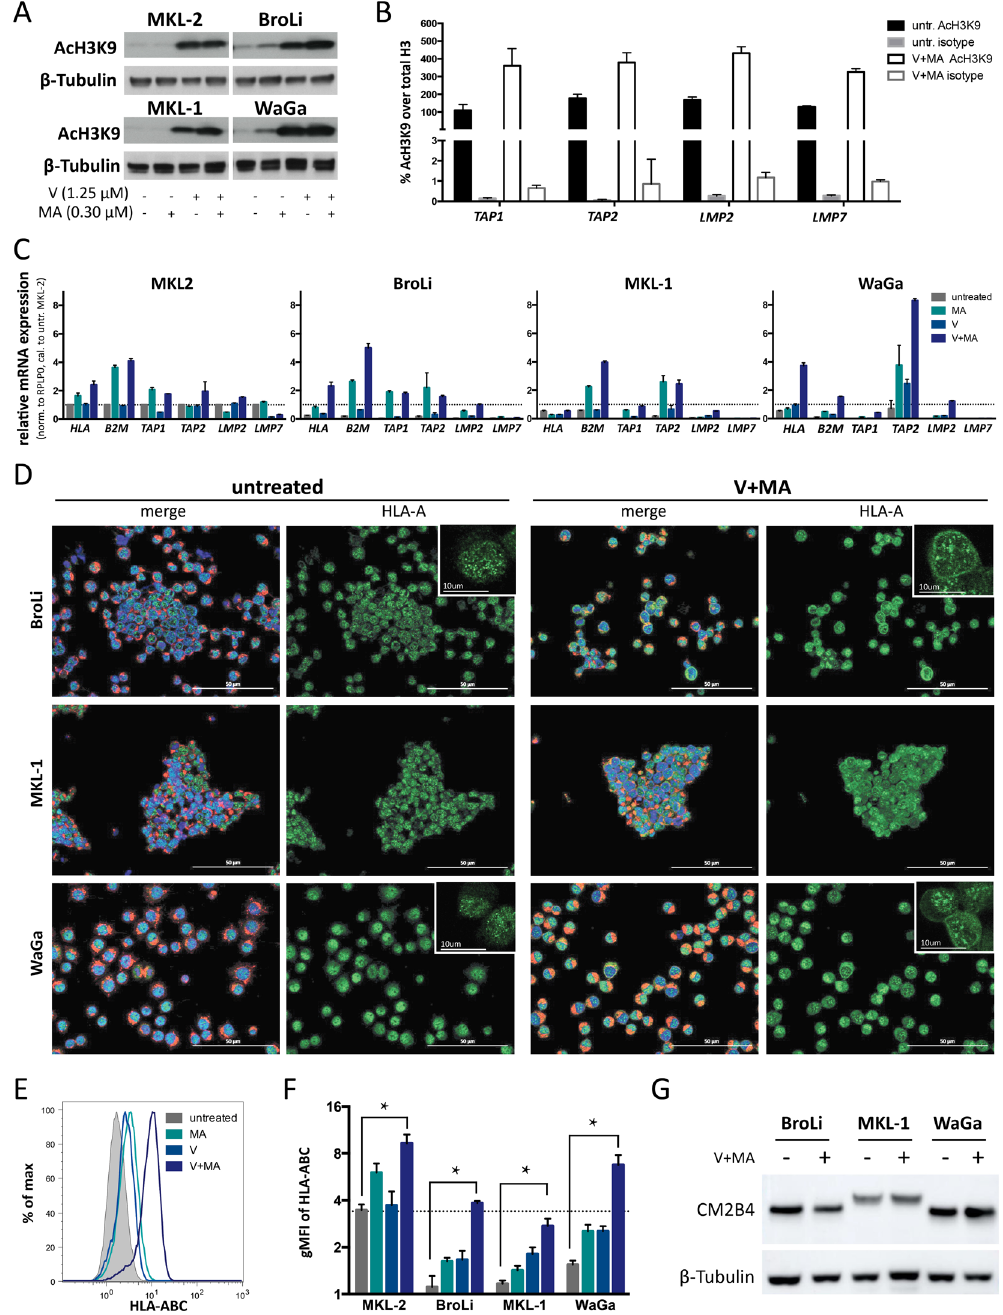
Figure 3. Reduced expression of antigen processing machinery genes is mediated by histone hypoacetylation and is increased by pharmacologic histone deactylase inhibition. For all experiments the indicated MCC cell lines were analyzed without treatment (grey) and after treatment with mithramycin A (MA, turquoise), vorinostat (V, light blue), or the combination thereof (V + MA, dark blue). ( A ) Global H3K9 acetylation of untreated, V, MA or V + MA treated MCC cell lines was determined by immunoblot with an AcH3K9 antibody; β -tubulin served as loading control. ( B ) Chromatin immunoprecipitation (ChIP) assay was performed with untreated or V + MA treated WaGa cells followed by a qRT-PCR using TAP1 , TAP2 , LMP2 or LMP7 promoter specific primers. C T values of AcH3K9 antibody or rabbit IgG isotype precipitated DNA were normalized to histone H3 antibody precipitated DNA as described in material and methods. Experiments were performed in triplicates twice and results are expressed as mean + SEM. ( C ) mRNA expression of HLA-A , B2M , TAP1 , TAP2 , LMP2 and LMP7 was determined by RT-qPCR in triplicates; C T values were normalized to RPLP0 and calibrated to the Δ C T value of untreated MKL-2 cells; relative mRNA expression is depicted + SEM for MKL-2, BroLi, MKL-1 and WaGa. ( D ) HLA class-I intracellular localization was determined via immunofluorescent staining using an HLA-A detecting antibody (clone EP1395Y) with a dylight 488 labeled secondary antibody (green). Wheat germ agglutinin (Alexa fluor 647, red) was used to stain cellular membranes and DAPI